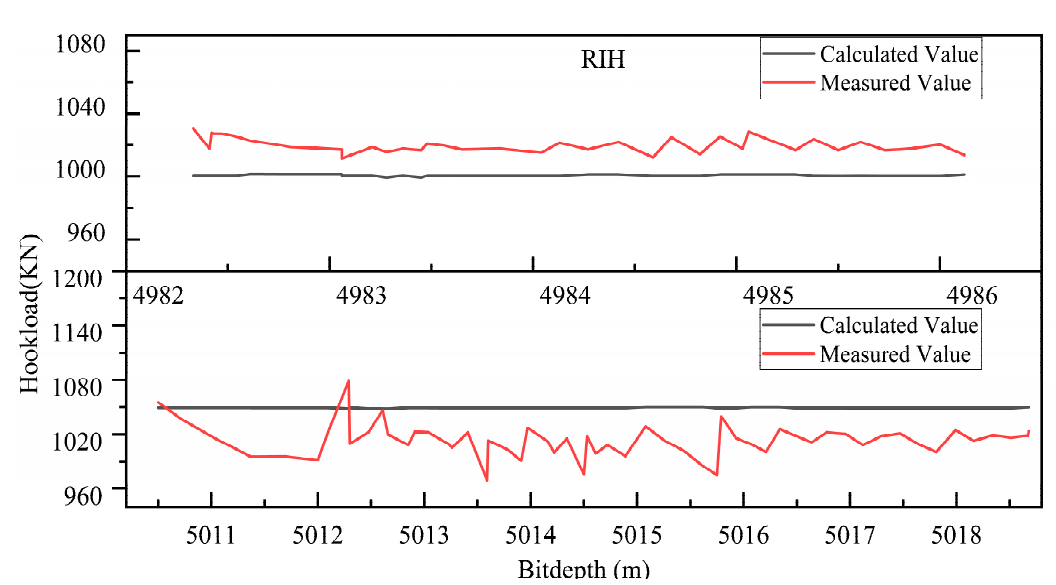
Figure 13. Stuck degree of RIH data for well N.